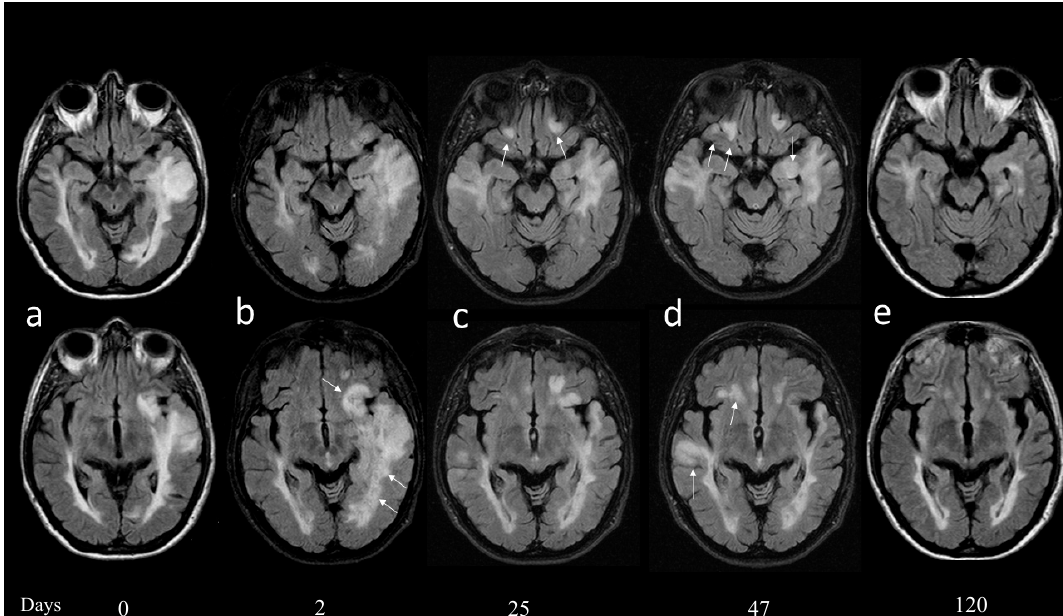
Figure 1. At admission ( a ) showed a large T2 signal alteration involving the left temporal lobe and expanding the superior temporal gyrus. ( b ) Two days later, a new brain magnetic resonance imaging (MRI) showed increased edema also involving the frontal subcortical and periventricular white matter ( b , arrows); compression of the ventricular system was increased; and no diffusion restriction or contrast enhancement was demonstrated. ( c) Twenty-five days after admission a new MRI showed reduction of the previously described T2 temporal lobe signal alteration with reduced compression of the temporal horn of the ventricle. Five new lesions were demonstrated and two of these were located in the fronto-orbital regions bilaterally ( c , arrows). ( d ) Forty-seven days after admission, a new MRI documented a worsening of the T2 signal alterations in the fronto-orbital and in the temporal region on the right, with mild contrast enhancement in the right hippocampus and cingulum cortex (not shown). ( e ) Four months after the beginning of symptomatology all the signal alterations were markedly reduced and no enhancement was evident.